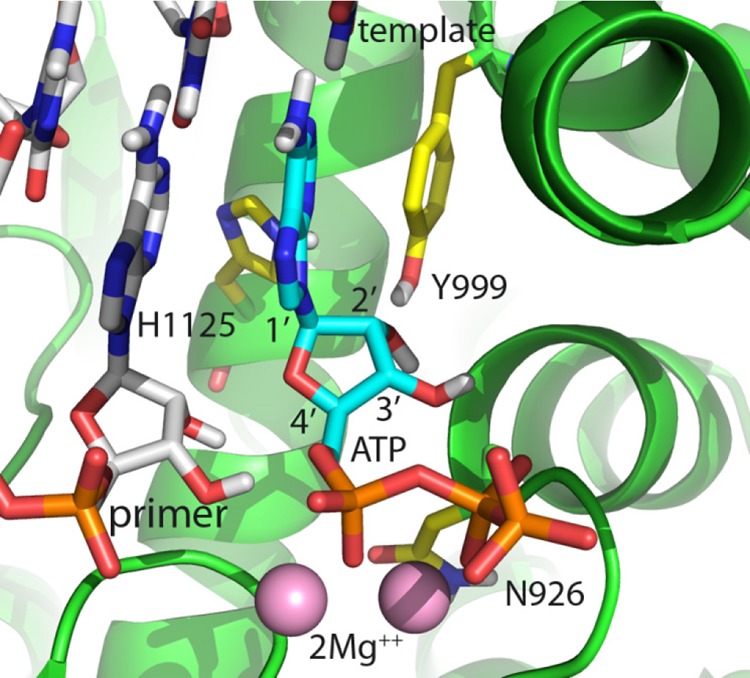
Homology model of ATP incorporation into human PolMRT based on a crystal structure of T7 RNA polymerase (PDB ID 1S76). The active site is well conserved, with only N926 (shown) and Q992 (not shown, but positioned above the substrate/template bases) being different. A 1′CN substitution shifts H1125 toward 2′. A 2′CMe substitution shifts Y999 toward 1′. When combined, these two substitutions are then in conflict and the analog is a poor substrate.